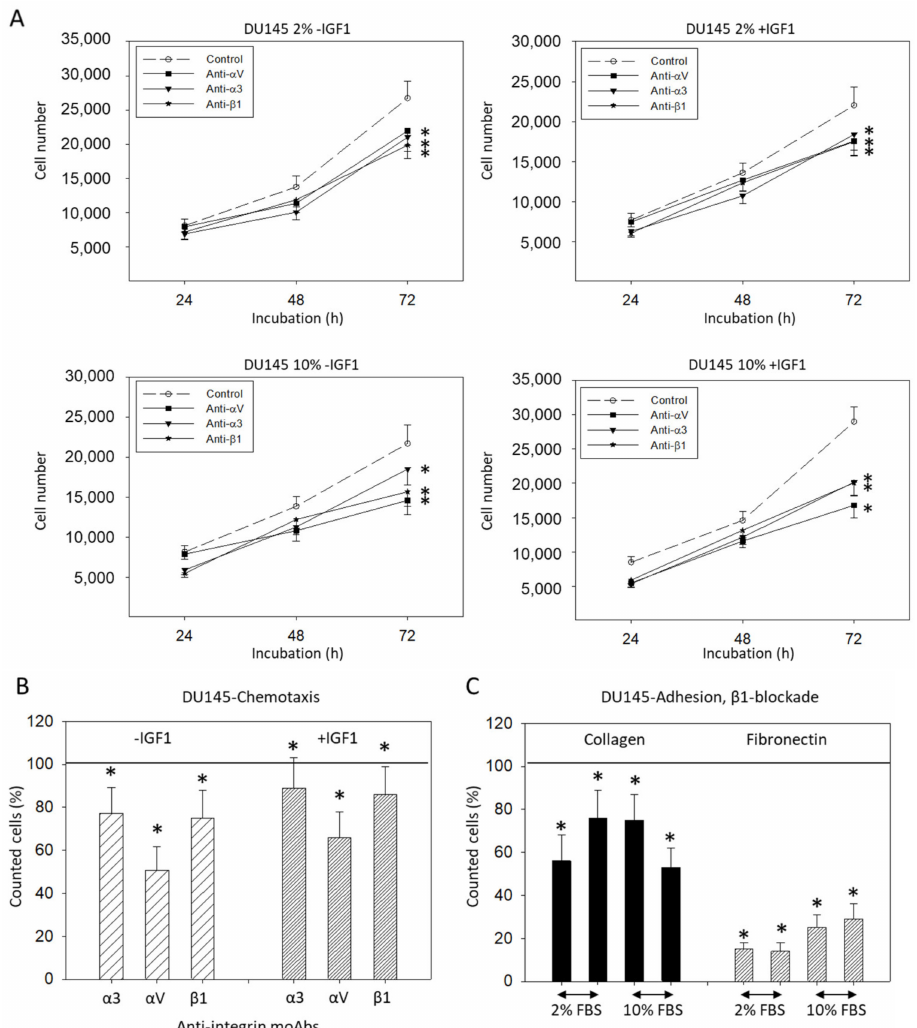
Figure 14. ( A ) DU145 cell number in response to integrin blockade. Tumor cells were grown in 2 or 10% FBS and in the presence or without IGF-1. Untreated cells served as controls. Cell number was evaluated after 24, 48, and 72 h by the MTT assay. ( B ) Chemotactic movement of DU145 cells after blockade through monoclonal antibodies (specific blockade against α 3, α V, or β 1) with or without IGF-1 activation. ( C ) Adhesion modulation of DU145 through integrin β 1 blockade in the presence of 2 versus 10% FBS. ( B , C ) are related to the non-blocked controls set to 100%. Error bars indicate standard deviation. Experiments were repeated three times. One representative experiment is shown. * indicates p <